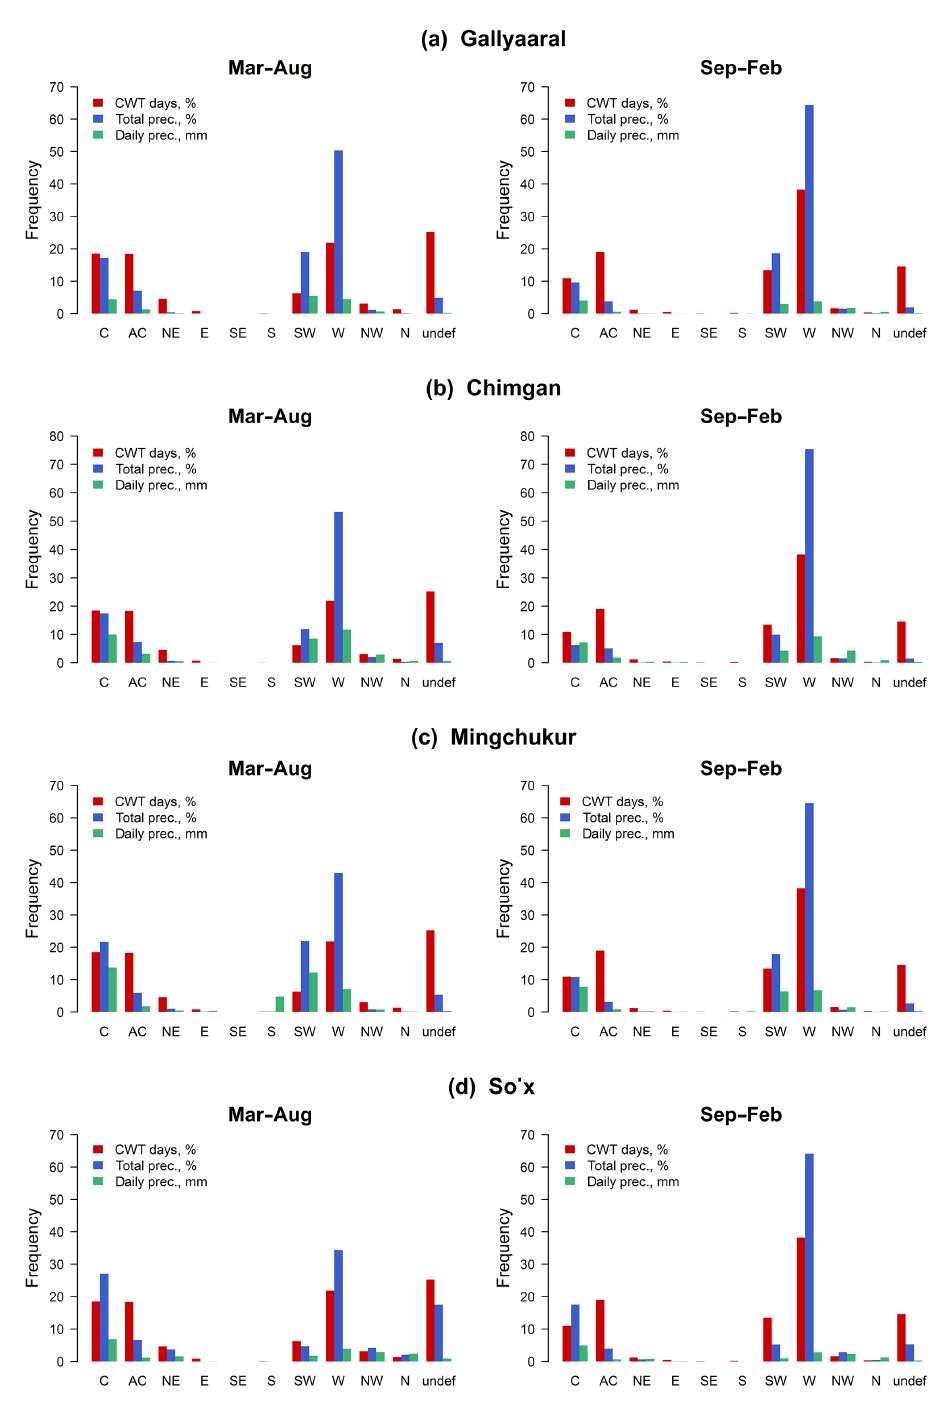
Figure 10. Contribution of CWT classes to the observed precipitation over the stations Gallyaaral in the Zerafshan basin (a) , Chimgan in the Chirchik–Akhangaran basin (b) , Mingchukur representing the Kashkadar’ya and Surkhandar’ya basins (c) and So’x in Fergana Valley (d) for warm (March–August) and cold (September–February) seasons for the years 1984–2013. CWT days – frequency of each class in percentage; % total precipitation – contribution of each class to the overall precipitation; mmday − 1 – daily average precipitation for each CWT. The panels have different